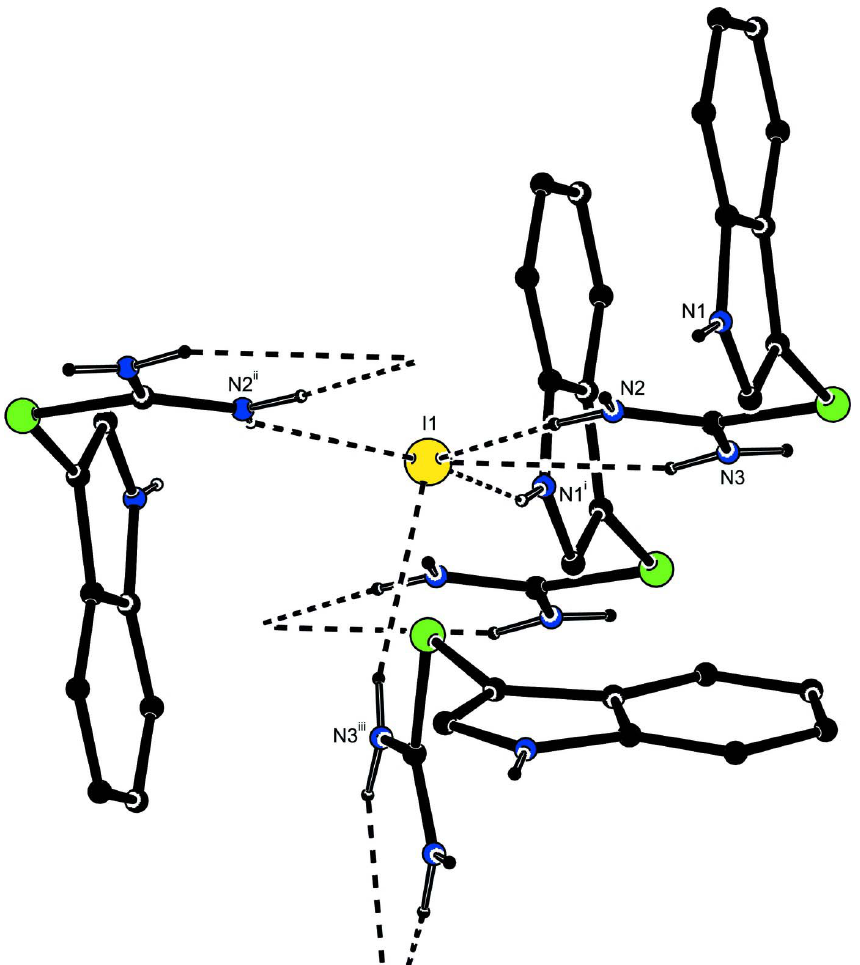
Figure 2 Hydrogen bonded environment of the iodide in (I). C—H hydrogen atoms are omitted for clarity. Symmetry operations i: 1 + x , y , z ; ii: 1 - x , 1 - y , - z ; iii: x , 0.5 - y , z -